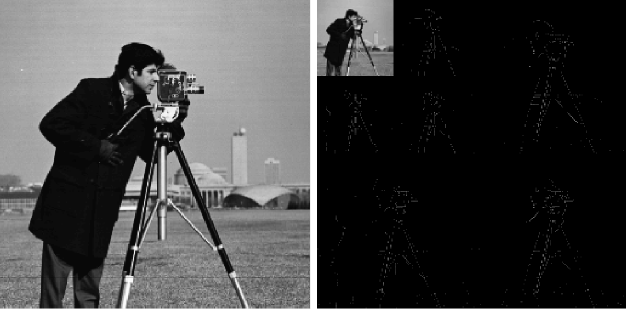
Figure 1. Multiresolution representation of the image of a cameraman using L = 2 scales. ( Left ) Original image. ( Right ) Multiresolution representation after L = 2